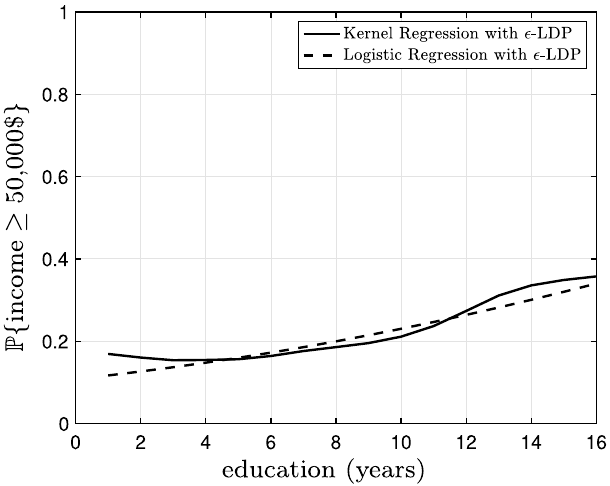
Figure 8. The kernel regression model (solid black) and the logistic regression model (dashed black) based on 5.0 bandwidth h 2.98 . The logarithm of the likelihood for the the ǫ -locally differential private data with ǫ = = 0.51 and the logarithm of the likelihood for the logistic regression model is kernel regression model is −